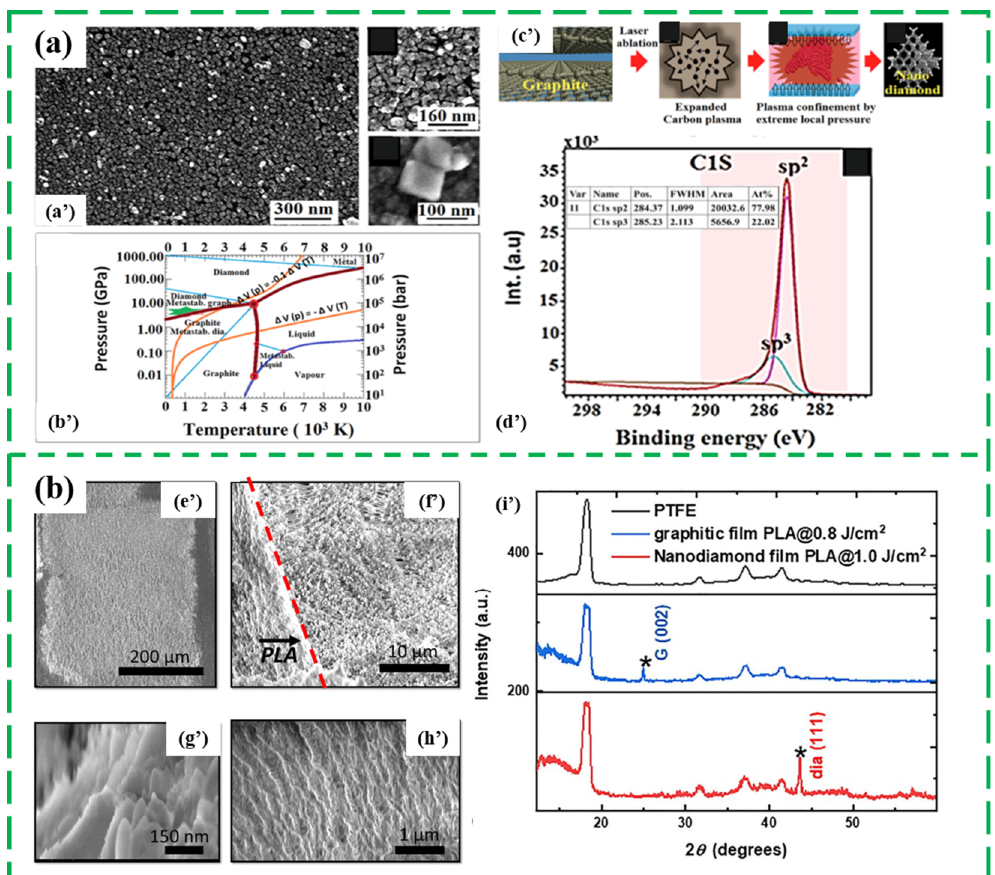
Figure 6. ( a ) The SEM images ( a’ ), phase diagram ( b’ ), schematic synthesis diagram ( c’ ) and the deconvoluted C1s spectra ( d’ ) of the ND films synthesized from graphite carbon [27], ( b ) The SEM images of laser patterned PTFE film ( e’ ), irradiated nanodiamond region and the PTFE boundary ( f’ ), liquid phase regrown nanodiamonds ( g’ ), and, as acquired, PTFE ( h’ ), and the XRD spectra of PTFE, PLA regrown diamond and graphitic films ( i’ ) [81].